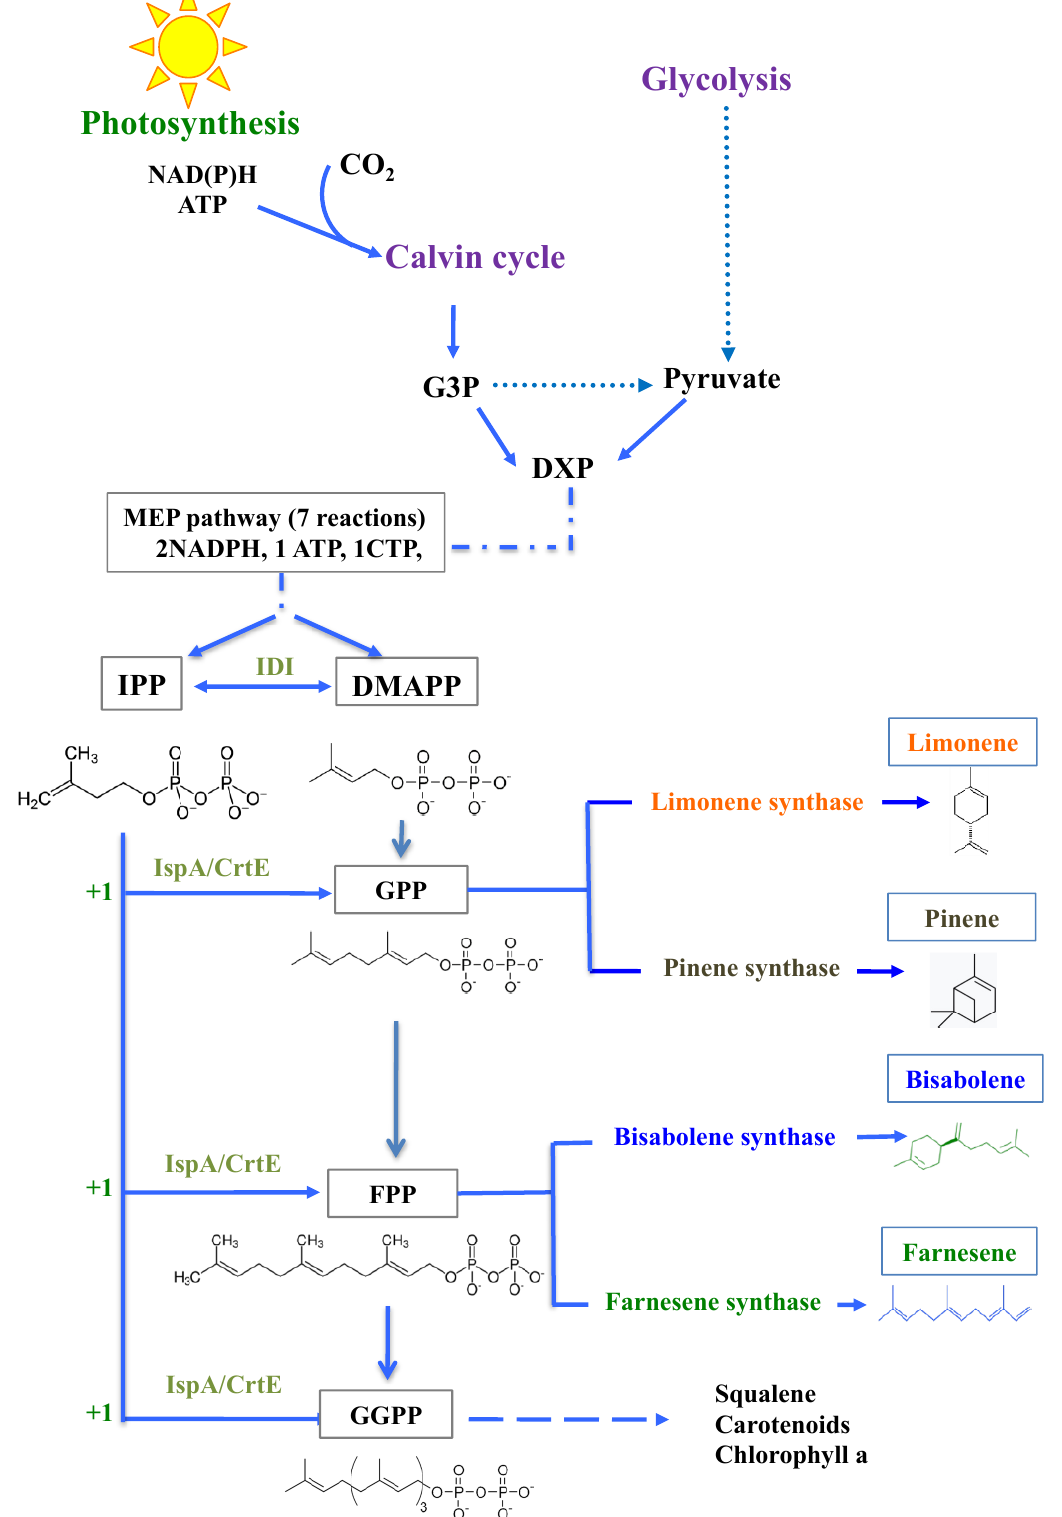
Figure 1. Schematic representation of the metabolic pathway and key compounds acting in the synthesis of terpenes from CO 2 . Abbreviations: DMAPP: dimethylallyl pyrophosphate; DXP: 1-